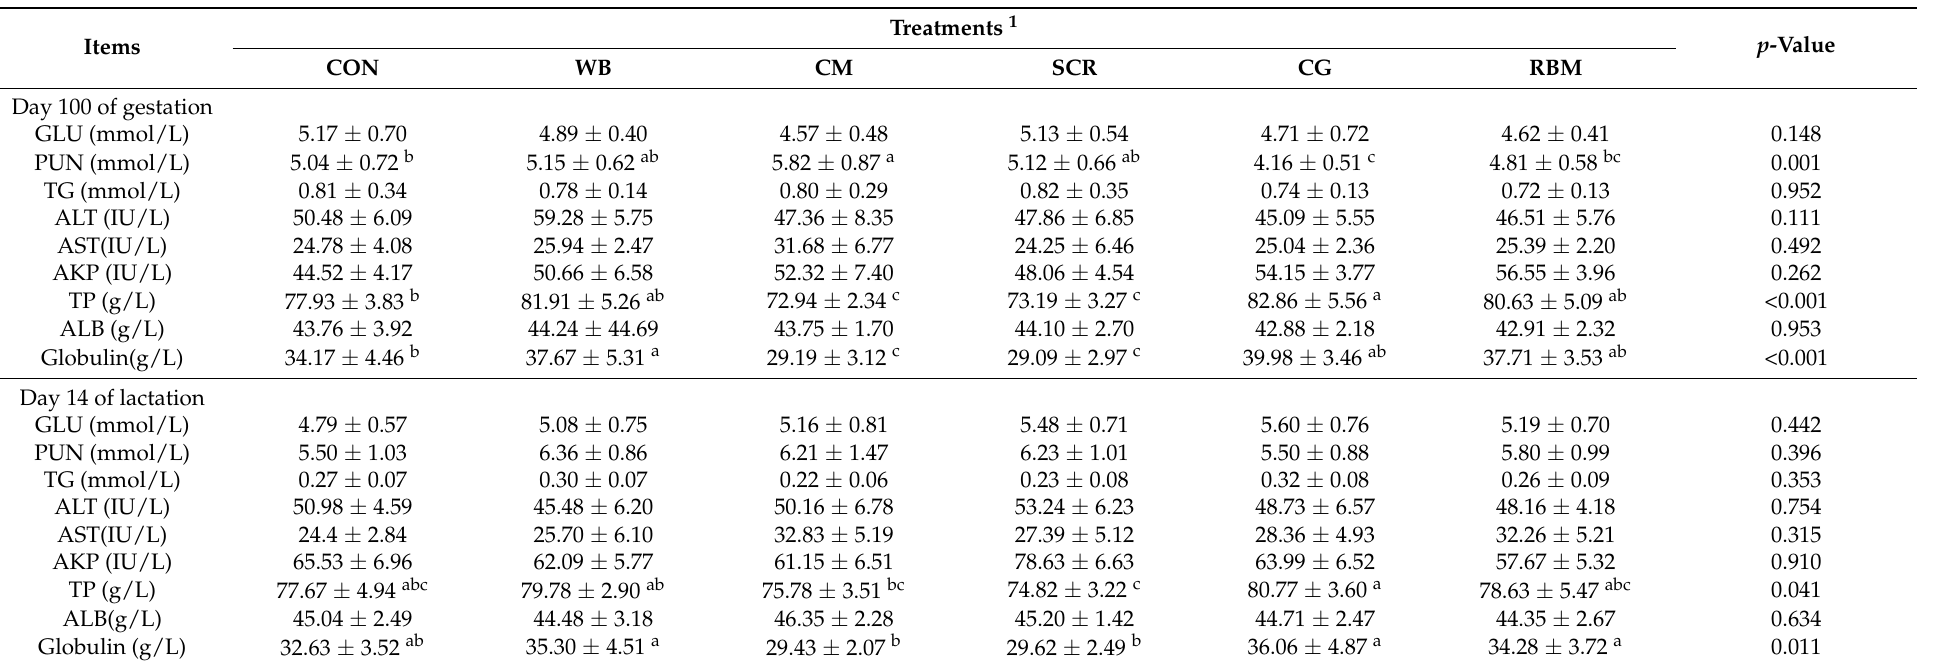
Table 5. Effect of different fiber sources on plasma biochemical parameters during gestation and